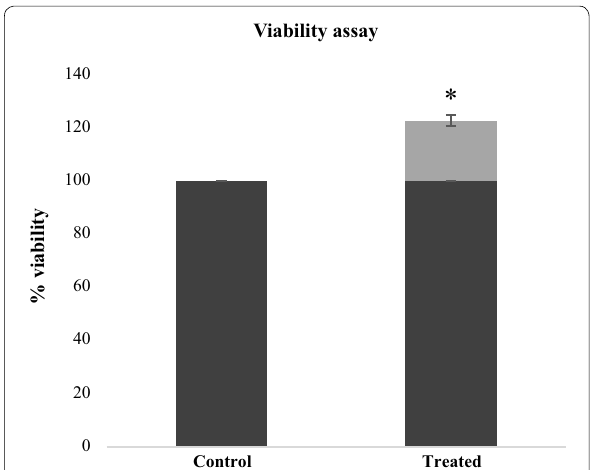
Fig. 6 Evaluation of cell viability on normal CCD 841 cell line after treatment with plantaricin P1053. MTT test was performed on normal CCD 841 cell line. Buffer NaCl 0.1 M pH 2 was used as control and it did not have any effect on cell viability. Values are presented as mean SD. Statistical analyses were performed using the Student’s ± t-test. * p <